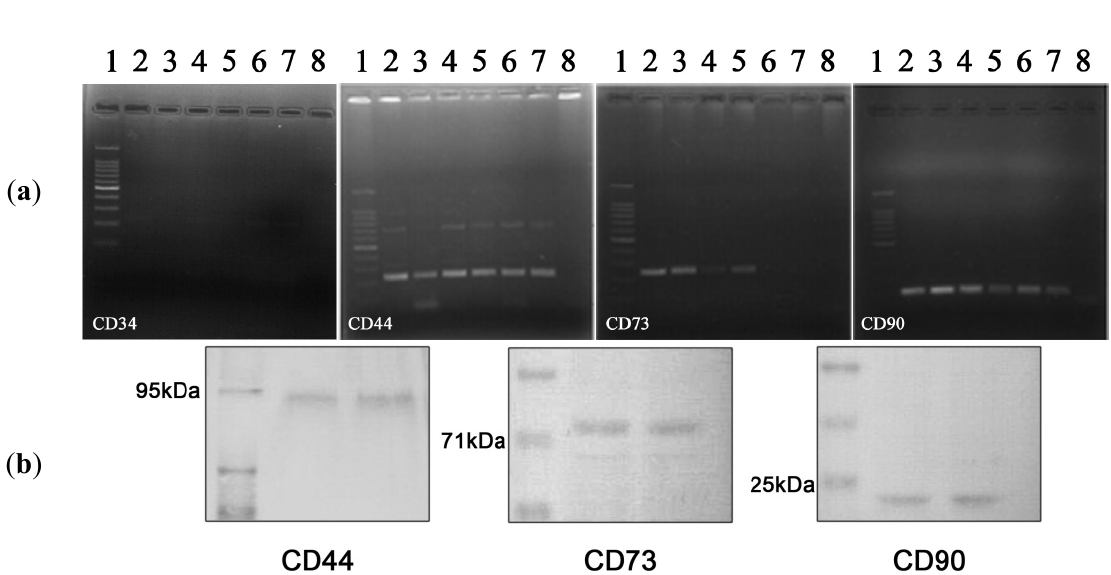
Figure 2. Phenotypic characterization of cultured hADSCs in third passage ( a ) Agarose gel electrophoresis of gradient RT-PCR products for CD34, CD44, CD73 and CD90; All surface markers were tested at 6 different temperatures in the range of 52–62 °C, as follows: (2) 54.9 °C; (3) 55.8 °C; (4) 56.6 °C; (5) 57.4 °C; (6) 58.3 °C; (7) 59.1 °C,